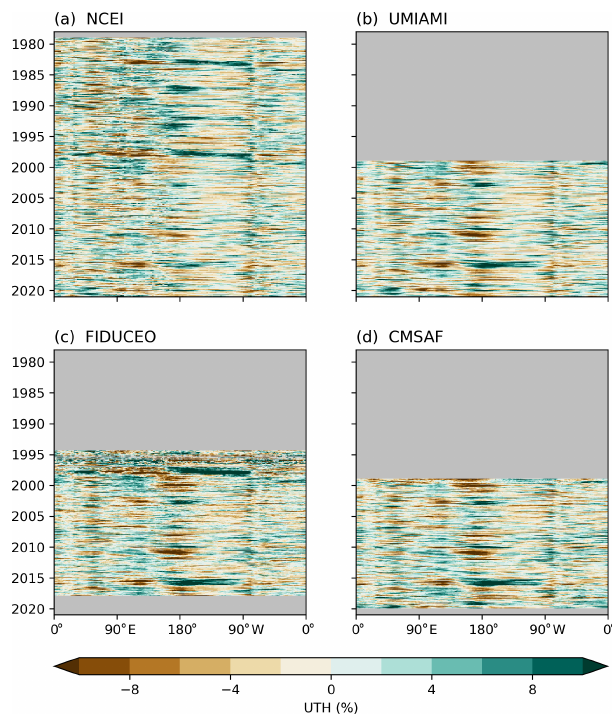
Figure 3. Time versus longitude section of UTH monthly anomaly. The analysis is based on an average of data between 5 ◦ N and 5 ◦